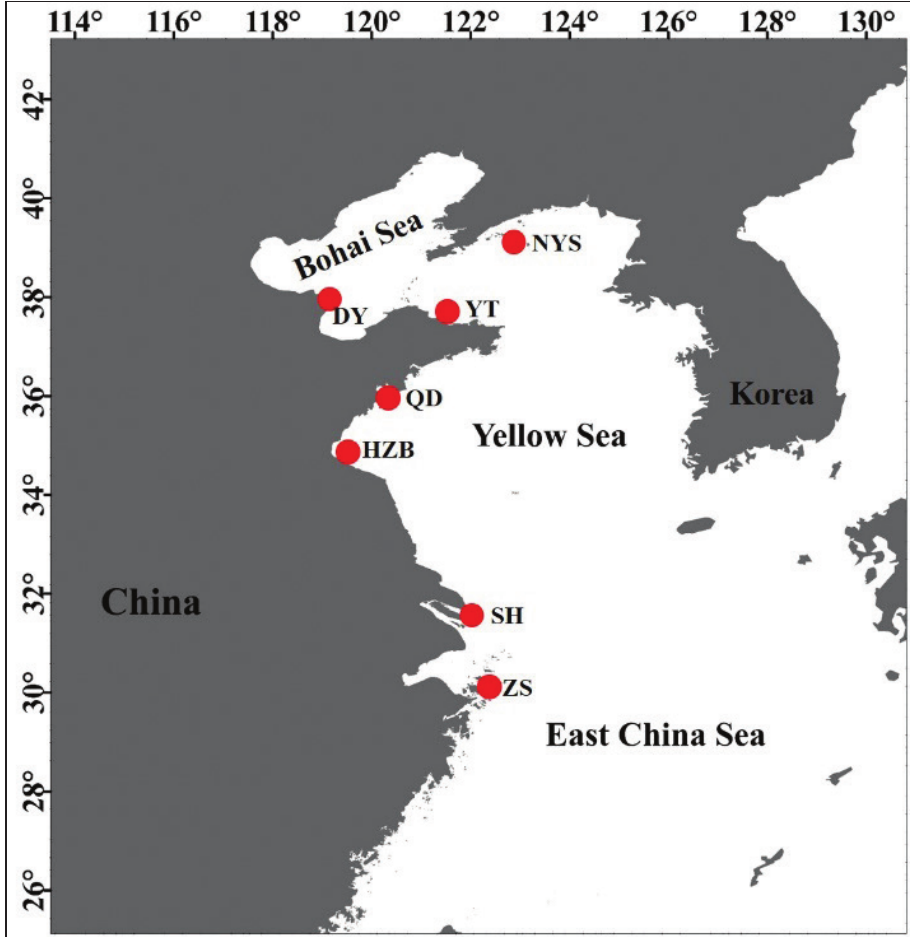
Figure1. Sampling sites of J.